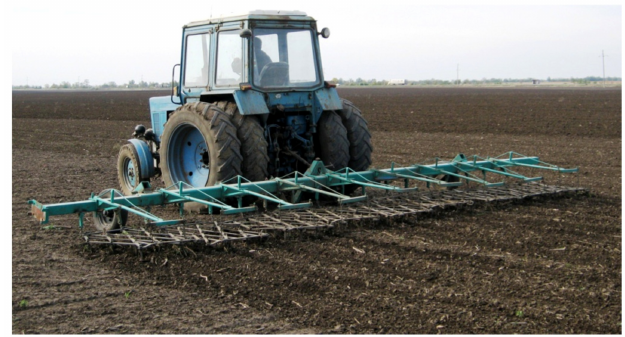
Figure 3. Tractor with harrow for treatment fallow.